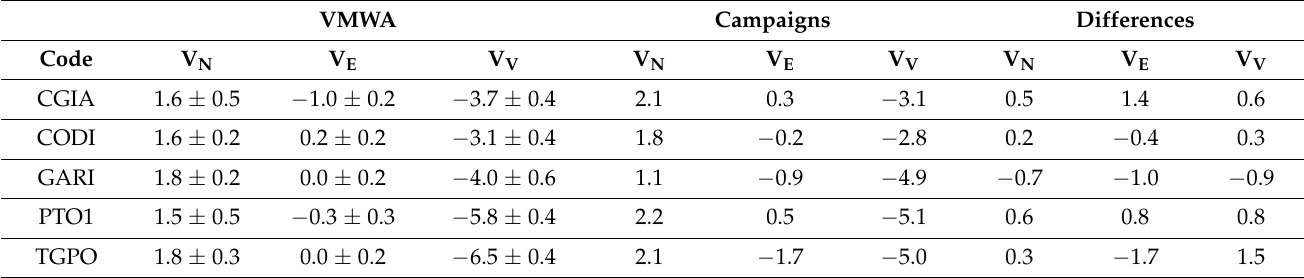
Table 2. Velocities of the three components (North V N , East V E, and Vertical V V ), in mm/year, of the continuous GNSS stations estimated by means of the Velocity Moving Window Approach (VMWA columns) using a window of 755 days (from 21 June 2016 to 18 July 2018). The values of the CGNSS sites estimated using only the observations acquired during the two campaigns are shown in the Campaigns columns, in mm/year; in the last three columns (Differences) are reported the differences between the corresponding values. The uncertainties associated with the VMWA velocities were obtained by a weighted least square approach adopted in the estimation of the velocities. VMWA Campaigns Differences